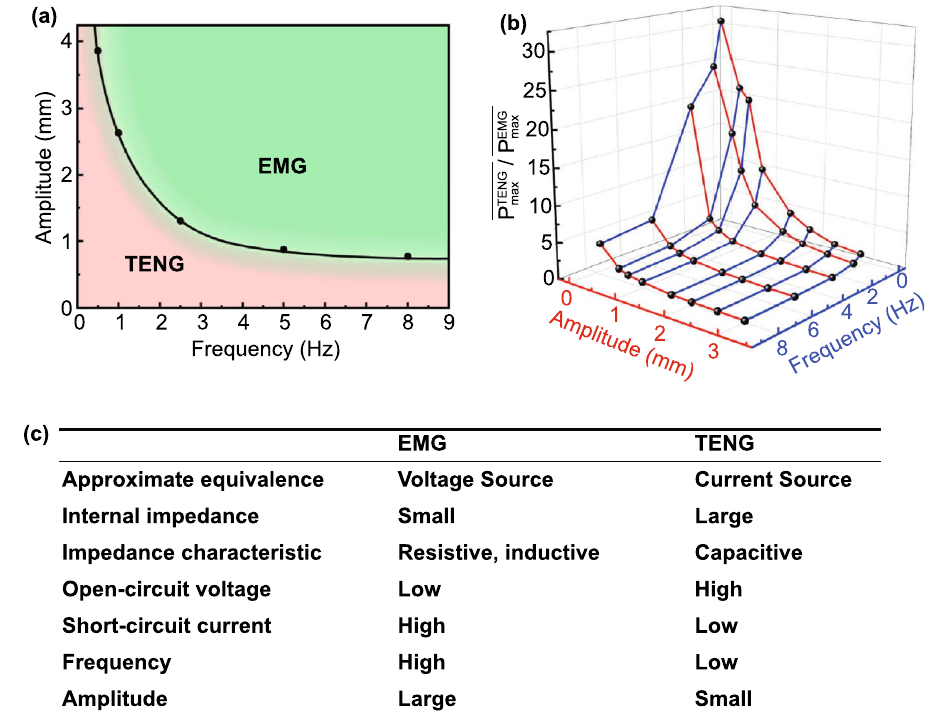
Fig. 1 a Domain of excitation amplitude and frequency values where the energy harvesting performance of a test EMG or TENG is superior. The light red area denotes the dominant scope of the TENG in low-frequency and small-amplitude while the light green area denotes that of the EMG. b Maximum average output power ratio of the EMG and TENG versus amplitude and frequency. c Summarized overall comparison table between the complementary characteristics of EMGs and TENGs. Reproduced with permission from Ref. [61]. Copyright 2019, Nano